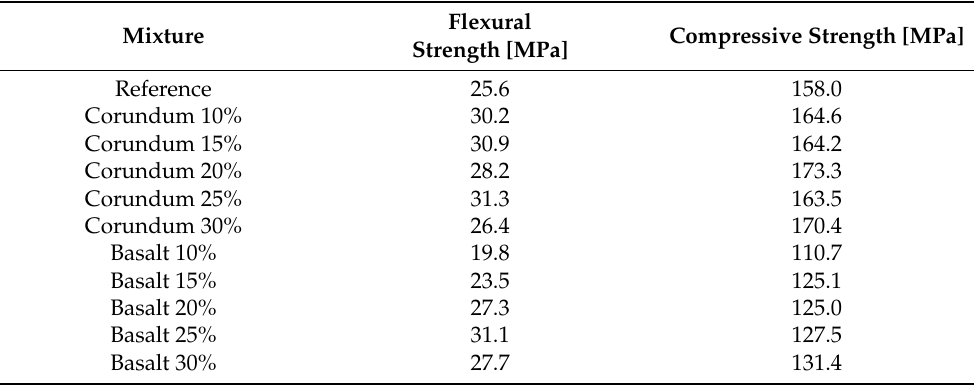
Table 2. Flexural and compressive strength of